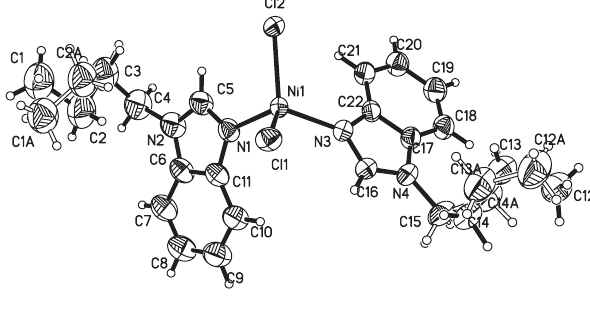
Table 1: Data collection and handling.